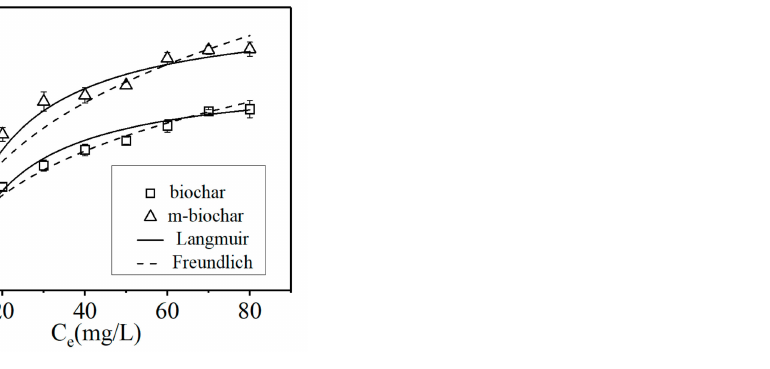
Figure 4. Langmuir and Freundlich nonlinear plots of adsorption isotherms for Cr(VI). The error bars represented the standard deviation. Table 3. Isotherm parameters for Cr(VI) adsorption on pristine biochar and m-biochar.